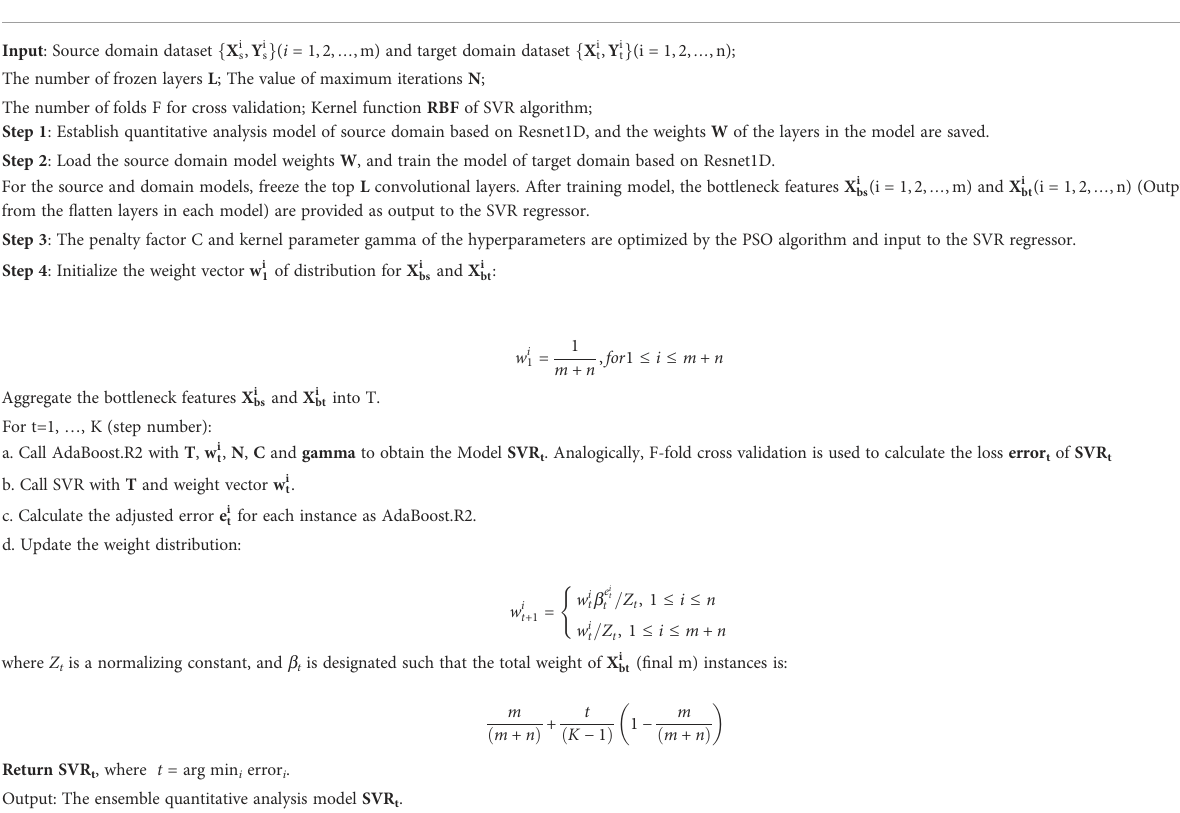
TABLE 1 Detailed steps of Resnet1D-SVR-TrAdaBoost.R2. Calibration transfer